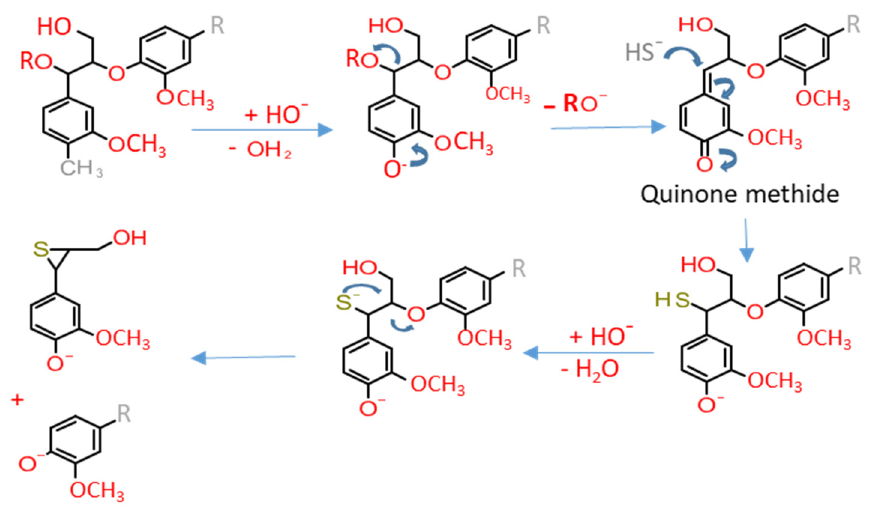
Figure 5. Cleavage of phenolic β -O-4 linkage during the kraft process [84]. Arrows represent reac- tions.